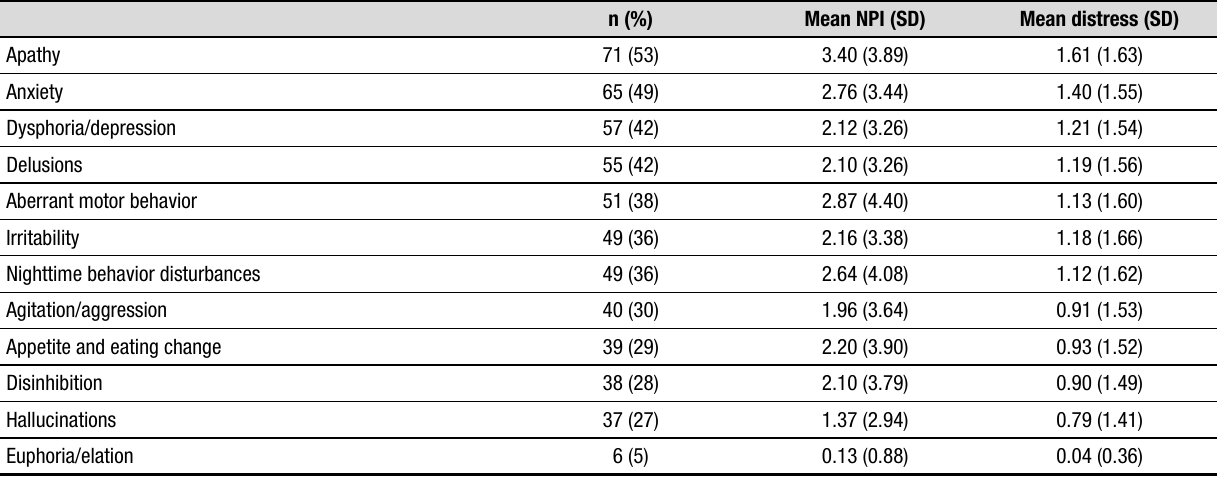
Table 2. Frequency of patients with neuropsychiatric manifestation and mean Neuropsychiatric Inventory score and distress reported by caregivers for each symptom. n (%) Mean NPI (SD)